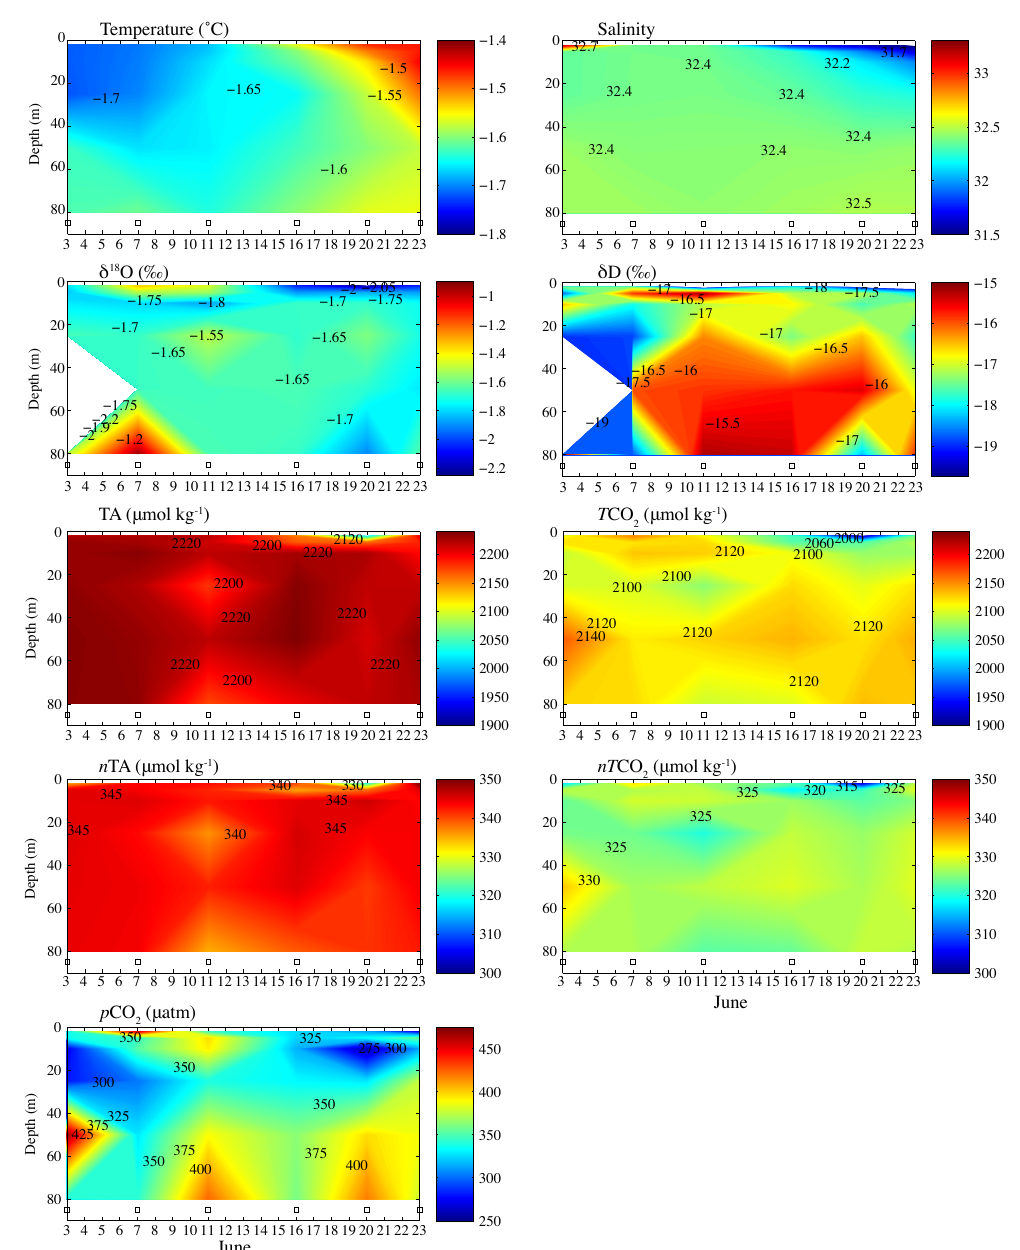
Figure 6. Temporal evolution of water column temperature ( ◦ C), salinity, isotopic composition of δ 18 O and δD (‰), TA and n TA (µmolkg − 1 ), T CO 2 and nT CO 2 (µmolkg − 1 ) and calculated p CO 2 (µatm). Open squares on the x axis mark the sampling dates.